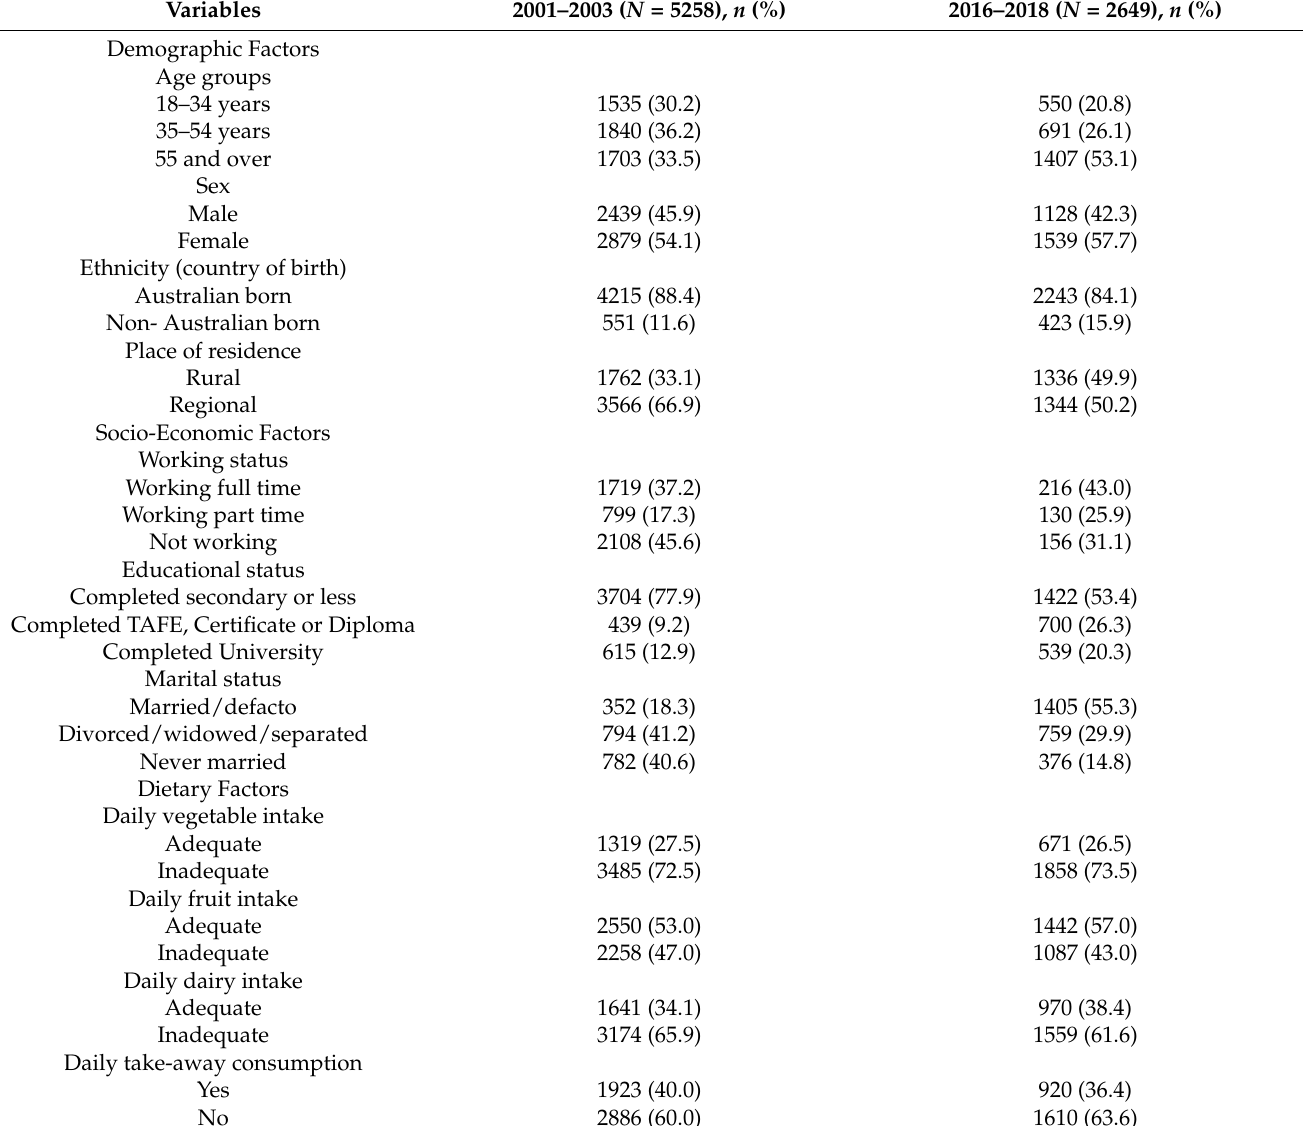
Table 1. Characteristics of the study sample in Crossroads 1 (2001–2003) and II